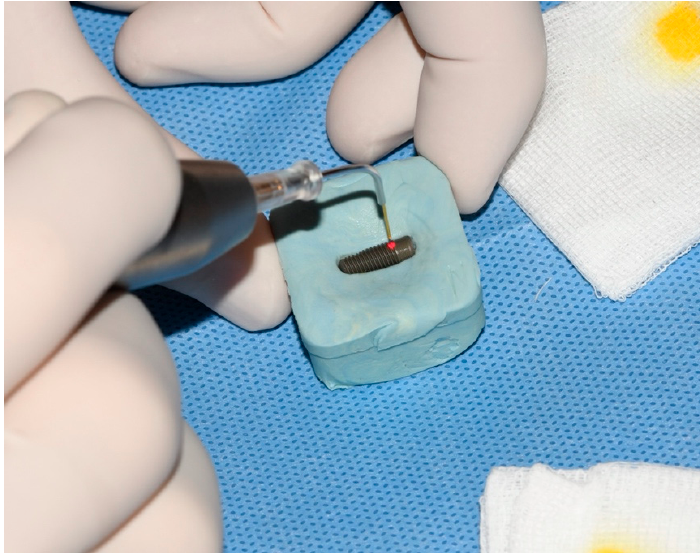
Figure 5. Treatment of implant surface with 445 nm diode laser for 60 s. Samples were collected using sterile plastic inoculating loops, with five horizontal brushing movements between the second and fifth implant threads. The samples were then immersed in 0.5 mL of sterile brain heart infusion. Each tube, containing the infusion and plastic inoculating loop, was then vortexed (Corning LSE vortex mixer, Corning, NY, USA) for 60 s (Figure 6).